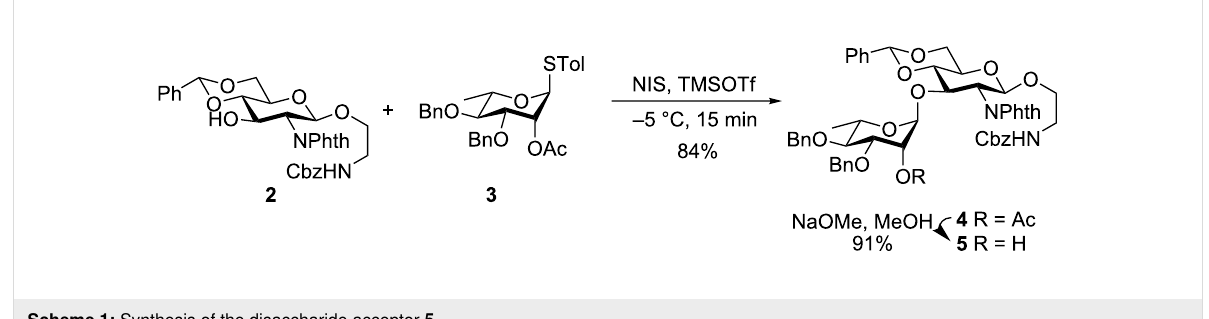
Scheme 1: Synthesis of the disaccharide acceptor 5 .